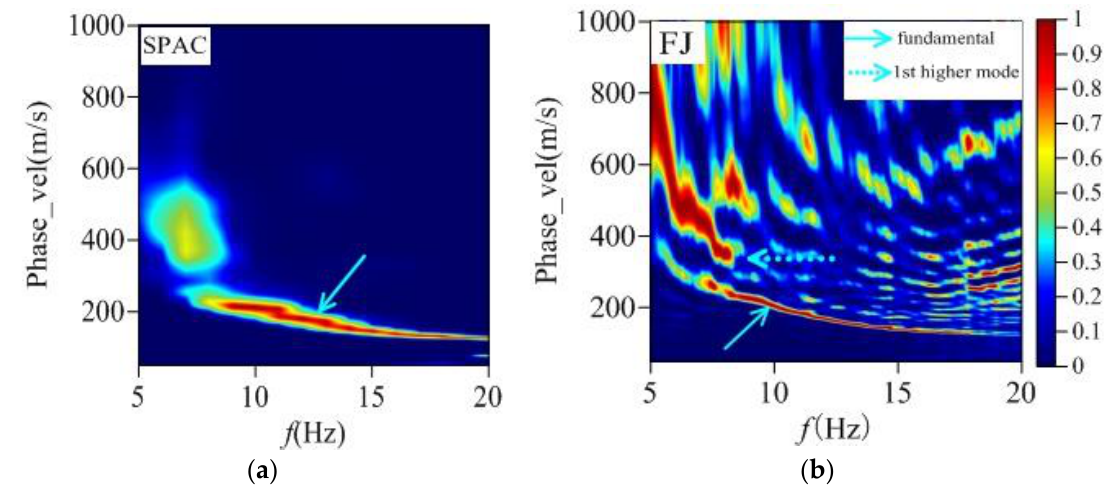
Figure 2. Dispersion spectrograms calculated by different methods. ( a ) Dispersion spectrum calculated by the spatial autocorrelation (SPAC) method. ( b ) Dispersion spectrum calculated by the frequency-Bessel method.